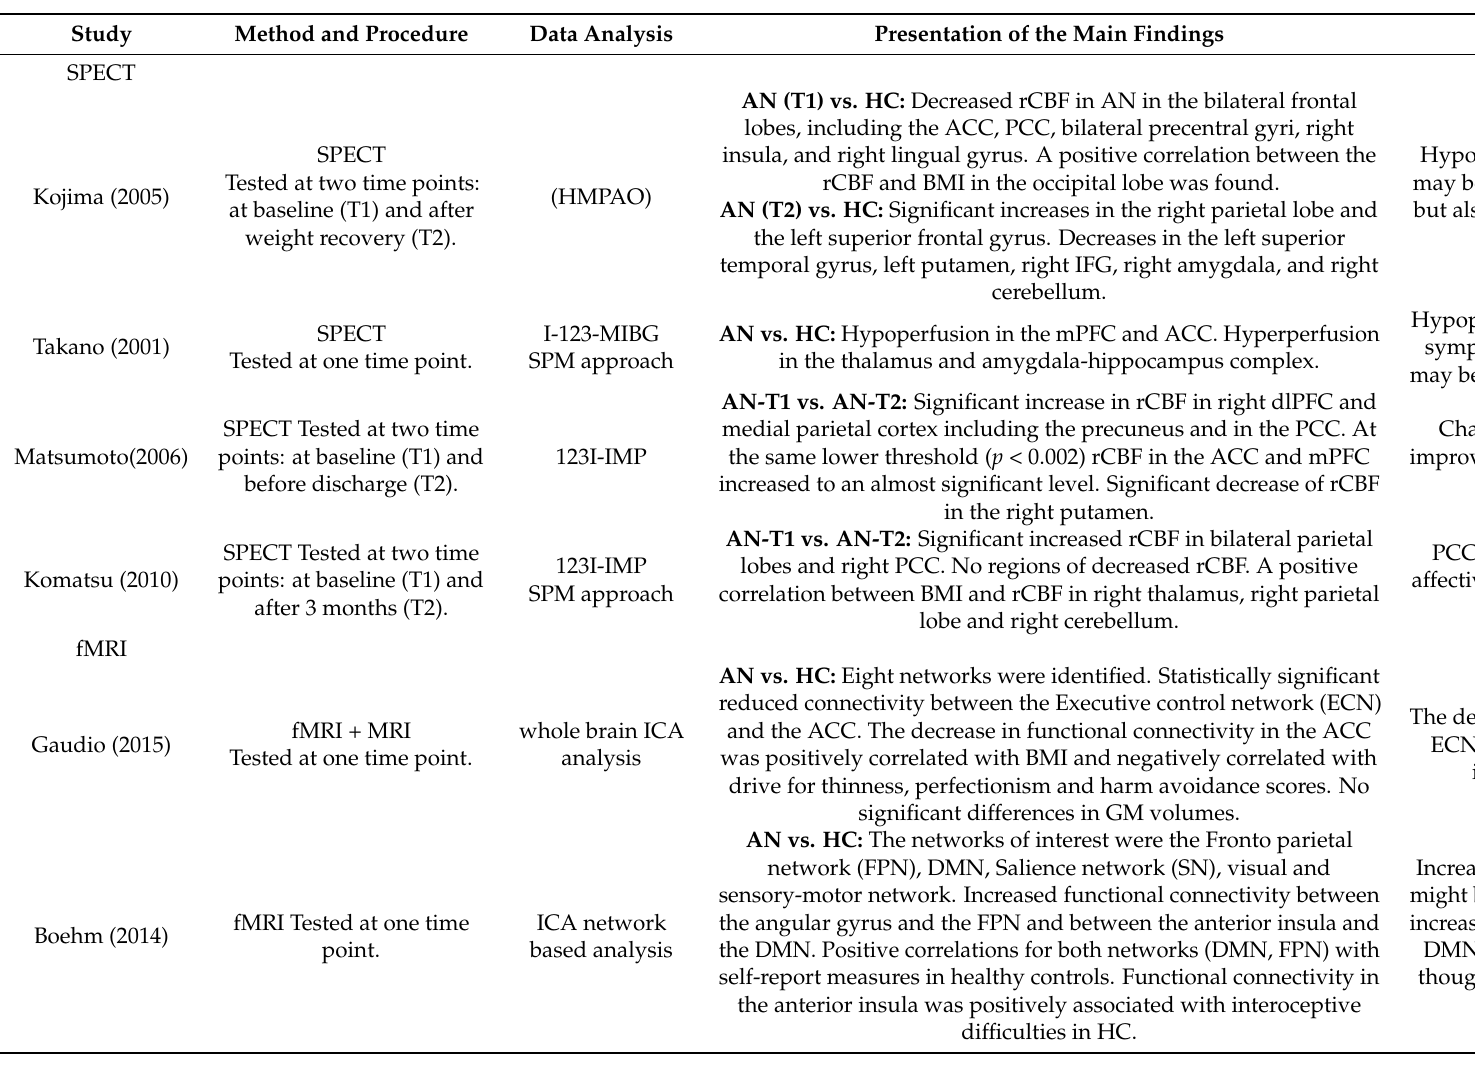
Table 4. Functional imaging studies—methods, main findings and clinical